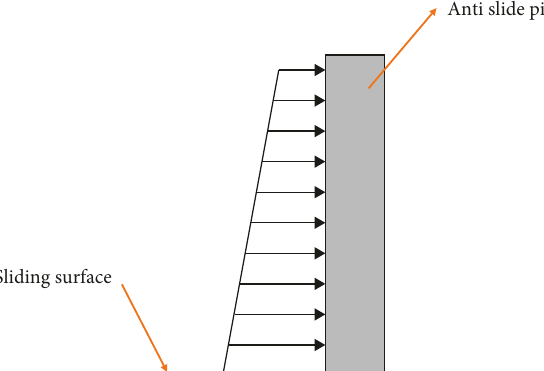
Figure 3: Trapezoidal distribution of landslide thrust.